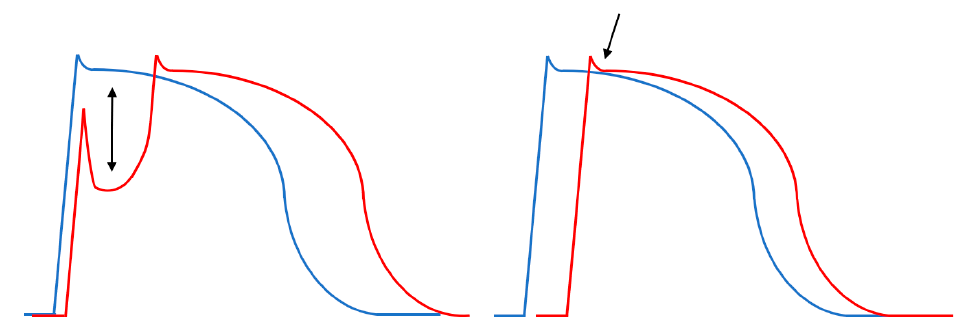
Figure 3. Schematic representation of J-wave genesis at the action potential level. The left figure shows the transmural voltage gradient, characteristic of the early repolarization theory. On the right is the delayed impulse conduction that occurs at the level of the epicardium. The epicardium is shown with a red line, the endocardium with a blue line. The arrows show the voltage (left) and temporal (right) differences in the background of J-wave formation.